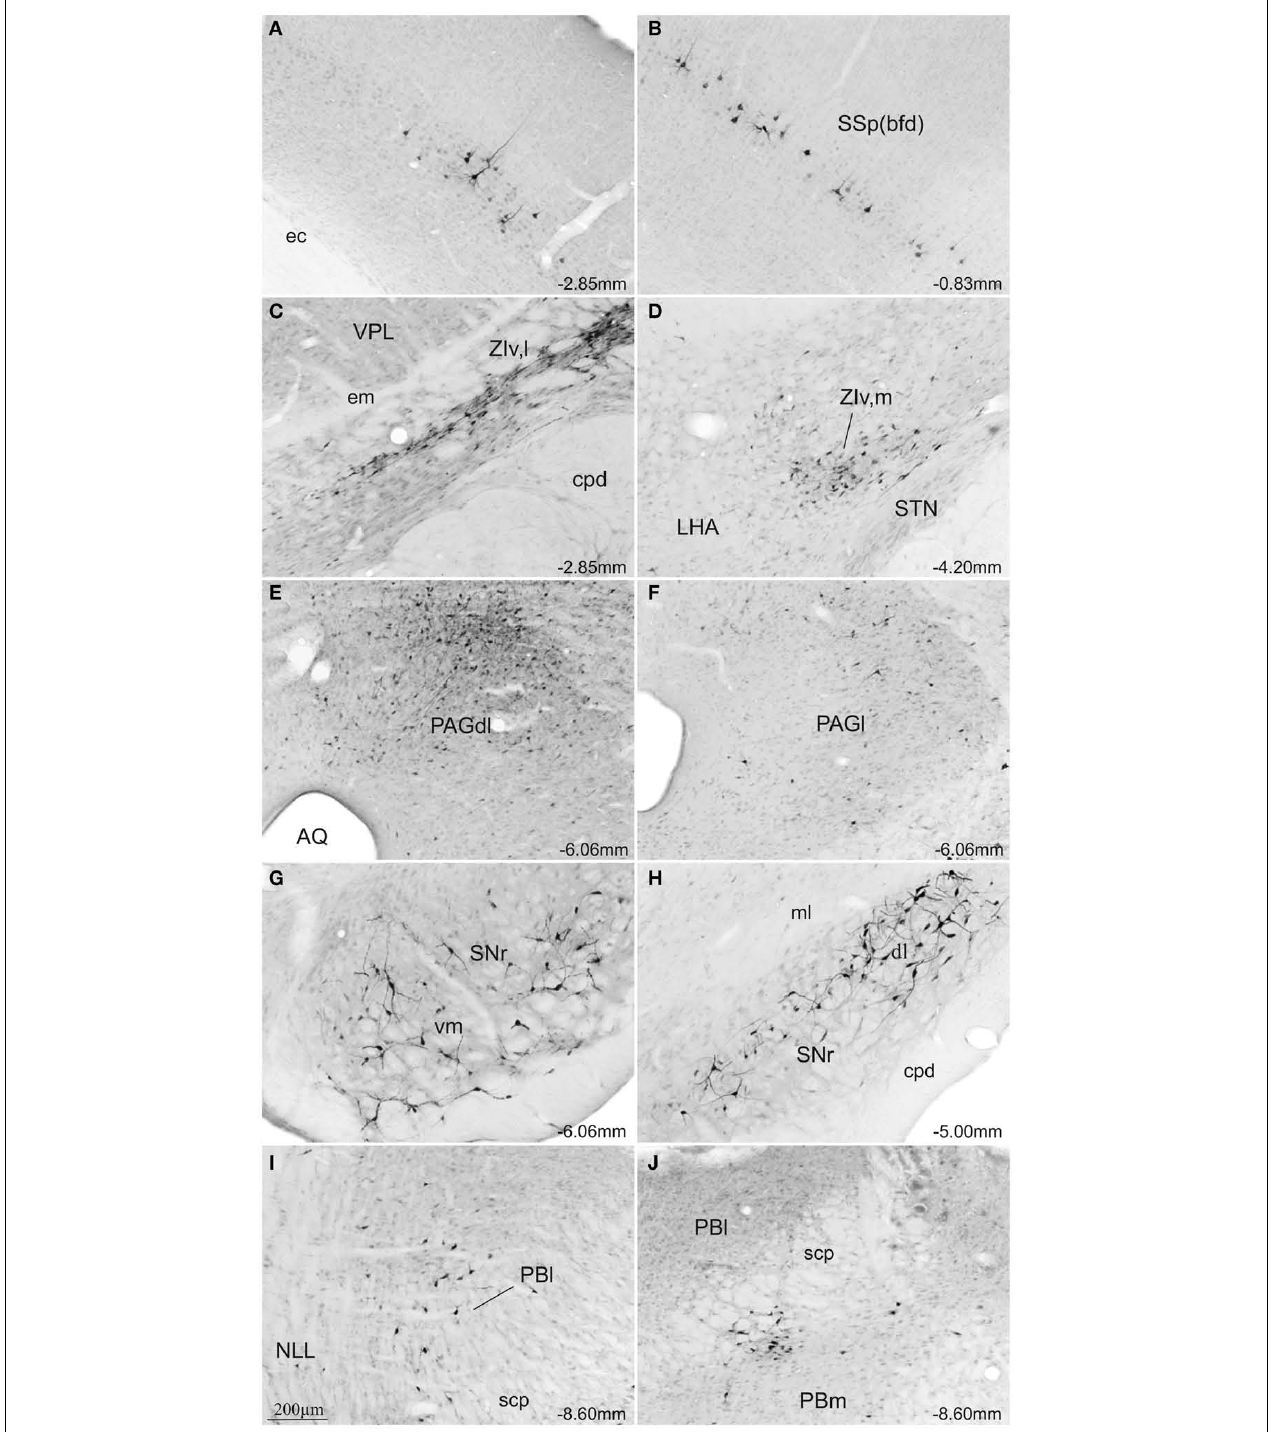
FIGURE 7 | Photomicrographs of transverse sections of the rat brain showing some of the areas with differential topography of FG-stained cells from a rat injected into the SCm (A,C,E,G,I) or into the SCl (B,D,F,H,J). Abbreviations: see list.